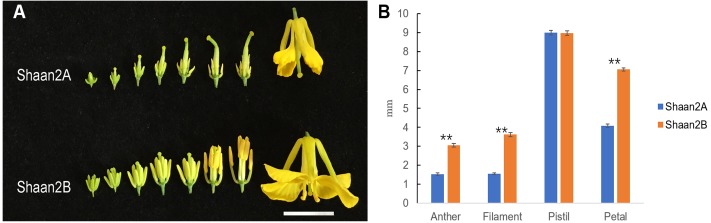
Phenotypic characterization of fertile and sterile buds. (A) Shaan2A and Shaan2B buds. Bar: 1 cm. (B) Length of anther, filament, and pistil, and width of petal in opened flowers (Student’s t-test,∗∗P < 0.01).